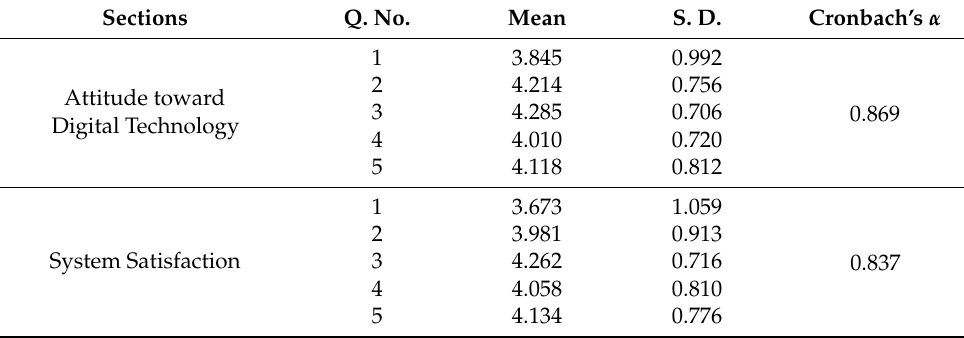
Table 4. Results of Questionnaire for System Satisfaction ( N = 55).